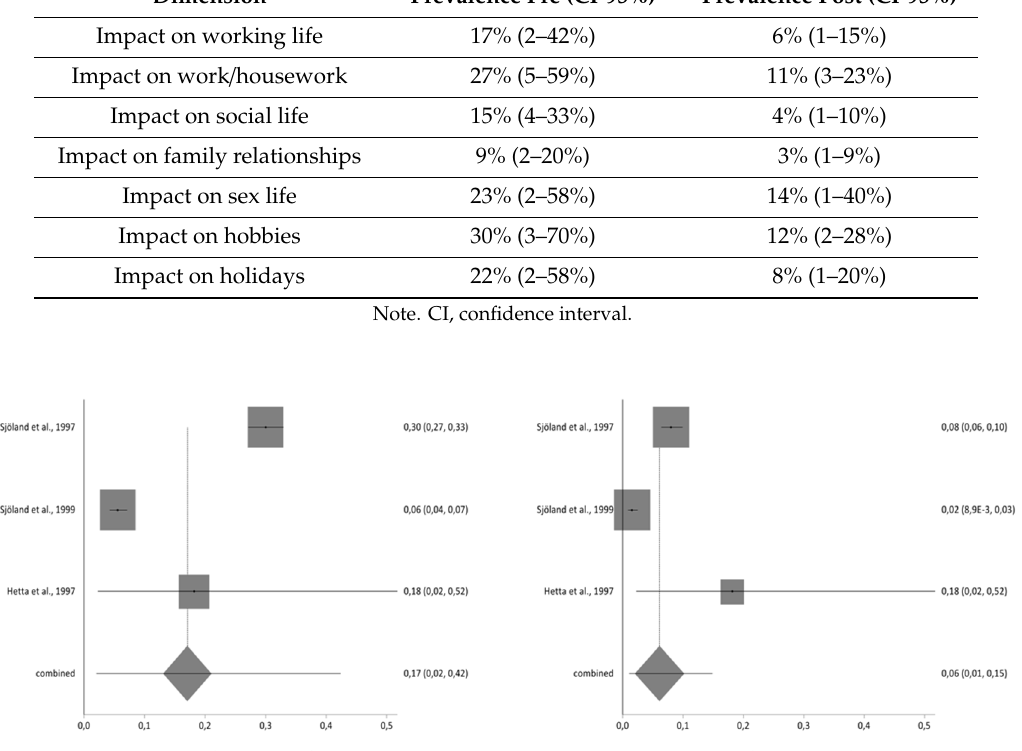
Table 2. Meta-analytical estimate of the impact on quality of life according to the 7 aspects of Part 2 of the NHP ( n = 1997).